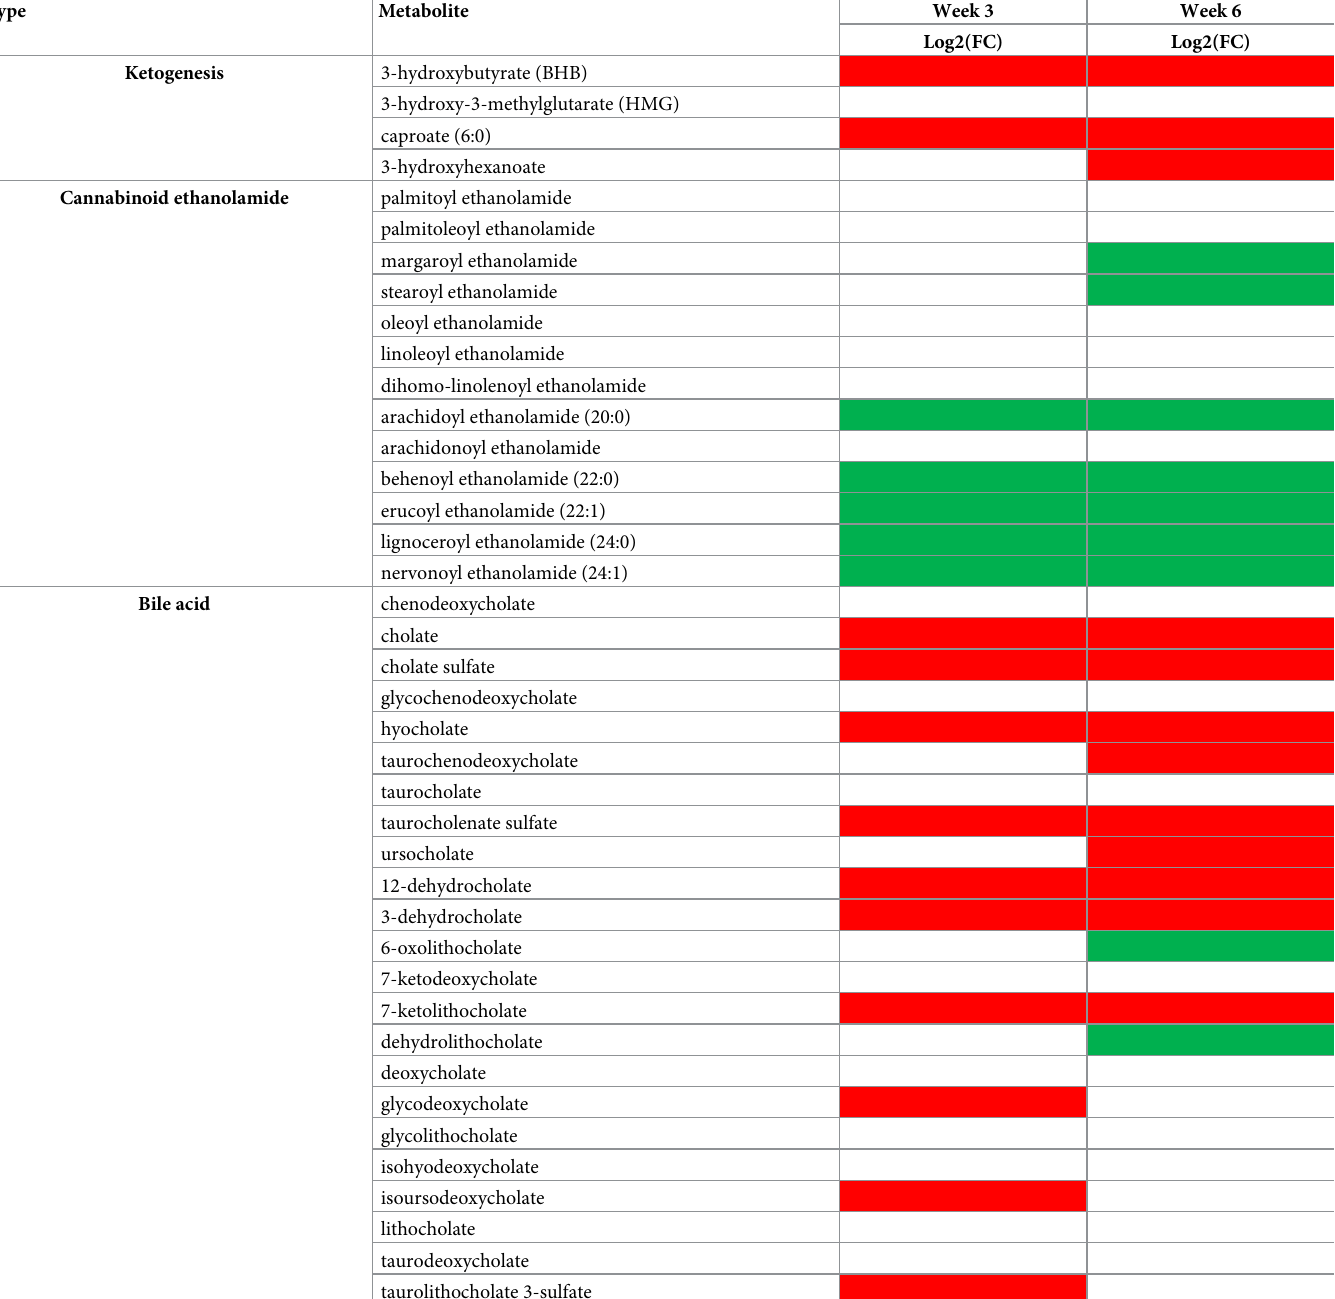
Table 7. Ketogenic metabolites, ethanolamides, and bile acids detected via metabolomic screening in fecal samples taken at weeks 3 and 6 from cats fed LRS or HRS